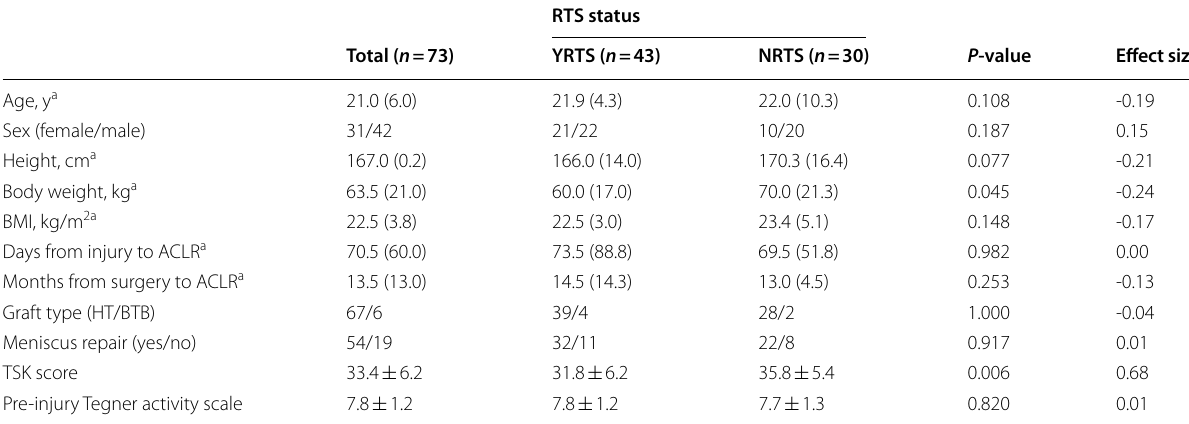
Table 1 Demographic variables distributions in